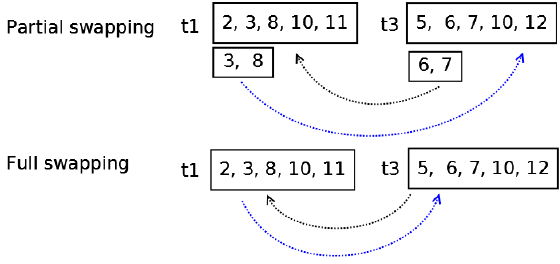
Figure 2. Swapping